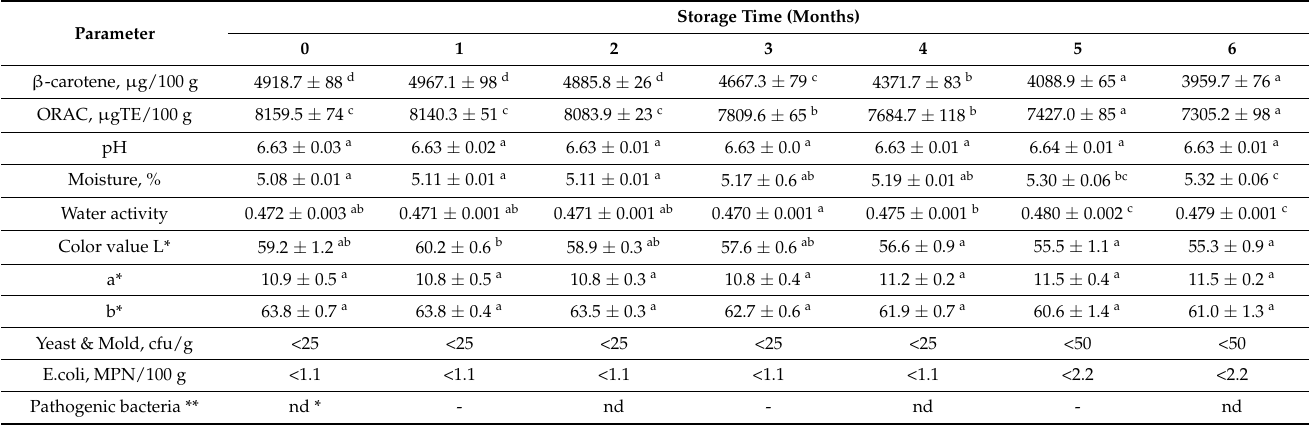
Table 6. Physicochemical quality and microbiological analyses of dehydrated soup powder during storage at 25 ◦ C for 6